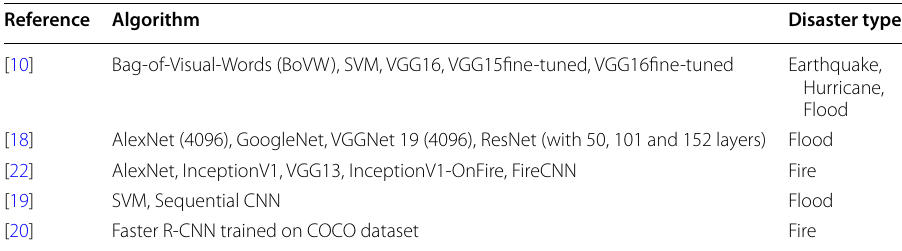
Table 1 Algorithms used for disaster classifications Reference Algorithm